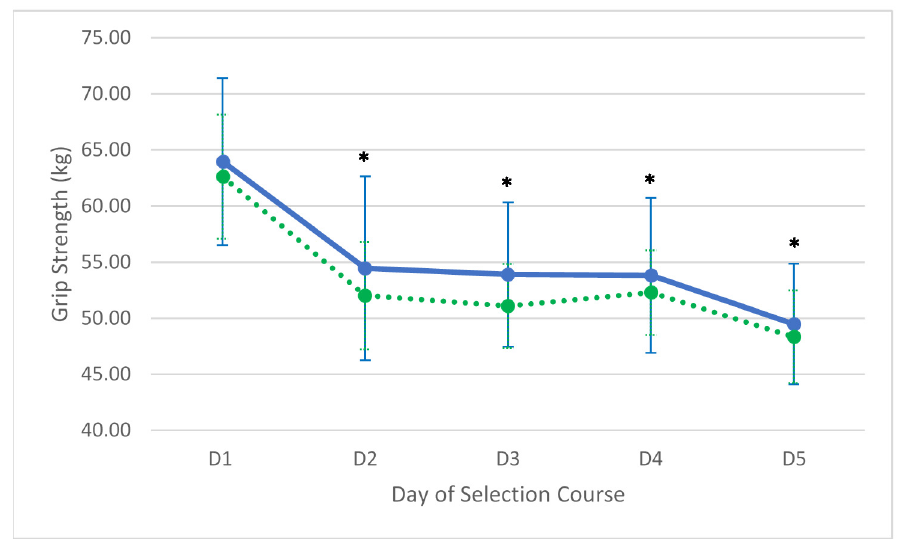
Figure 2. Average changes (±SD) in grip strength over the five days. The solid line is the right hand and the dotted line is the left hand. * = Significantly less than day one ( p < 0.05).